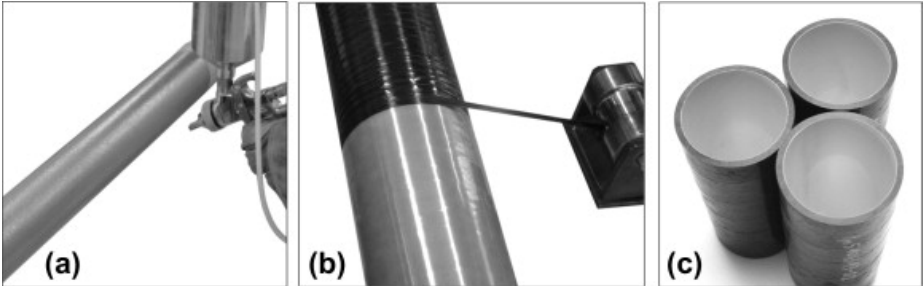
Figure 2. Manufacturing of CFRP barrels with internal nano-gelcoat: ( a ) sprayed application of particle–resin mixture; ( b ) filament-winding process; and ( c ) cylinders after curing and demolding [20].